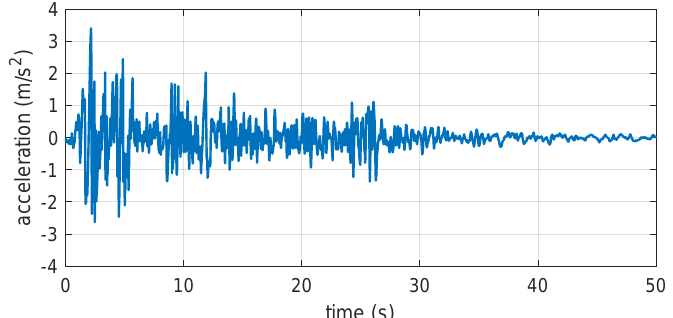
Figure 5. El Centro 1940 ground-acceleration seismic record, full-scale 180-component with an absolute acceleration-peak of 3.417 m/s 2 .